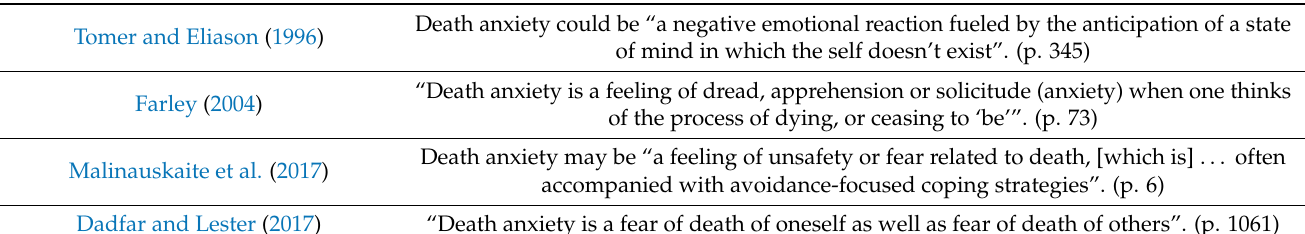
Table 1. Some definitions of death